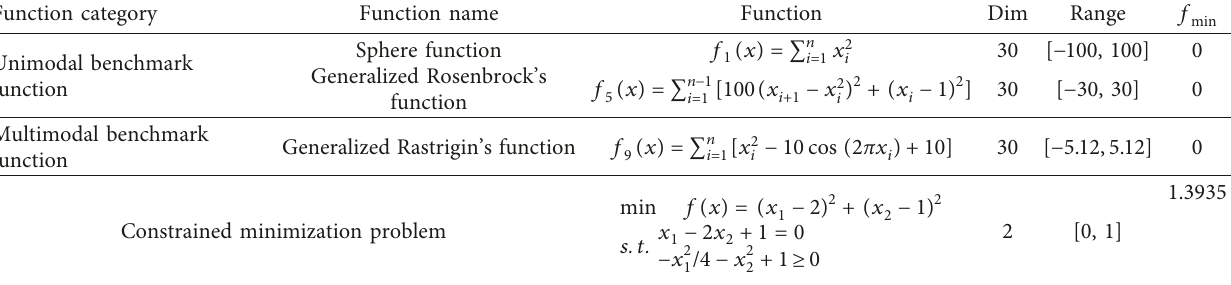
Table 3: The three benchmark